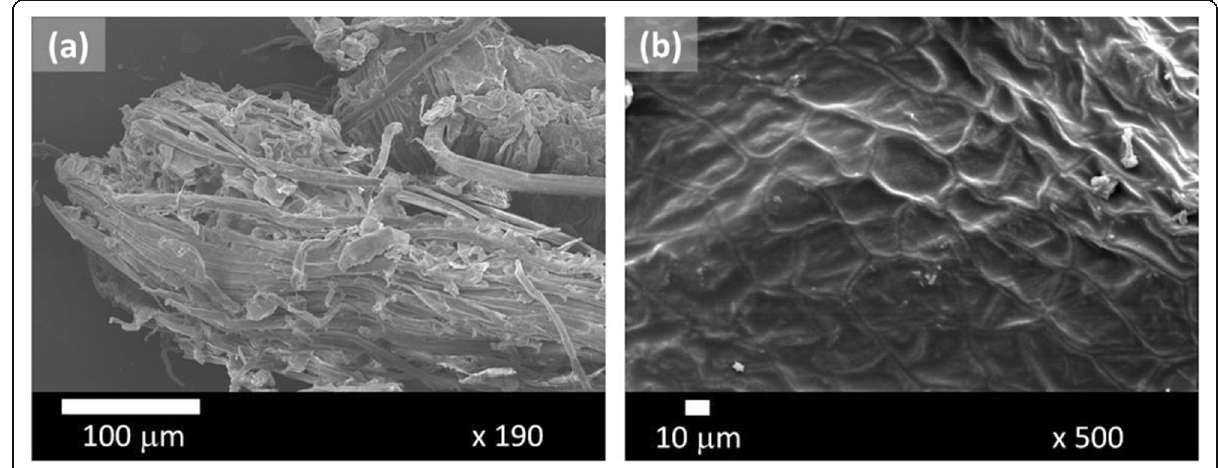
Fig. 2 SEM images of milled coffee husk particle (a) and particle surface